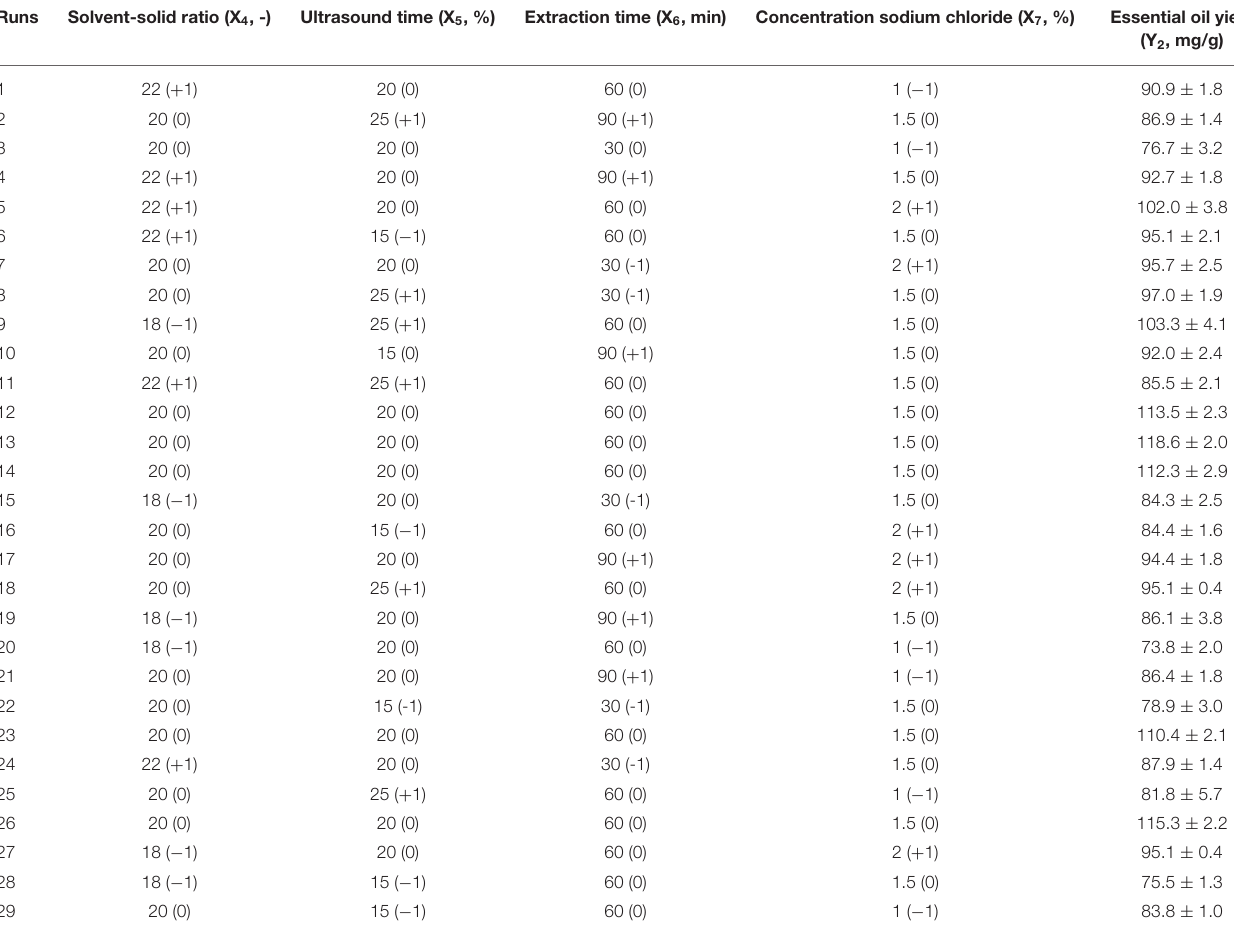
TABLE 3 | Box-Behnken experimental design matrix with experimental response for TCEO using ultrasound-assisted extraction. Runs Solvent-solid ratio (X 4 , -) Ultrasound time (X 5 , %) Extraction time (X 6 ,